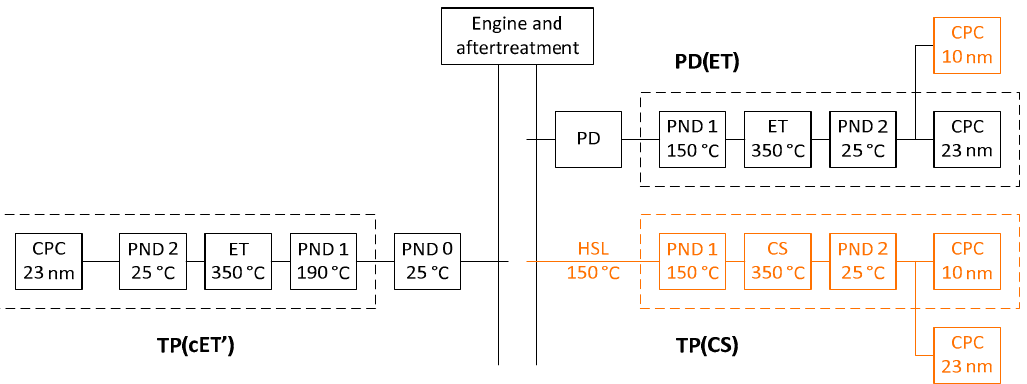
Figure 1. Experimental setup. “Golden” instruments in orange colour. CPC = Condensation particle counter; CS = catalytic stripper; ET = evaporation tube; PD = proportional partial flow dilution system; PND = particle number diluter.